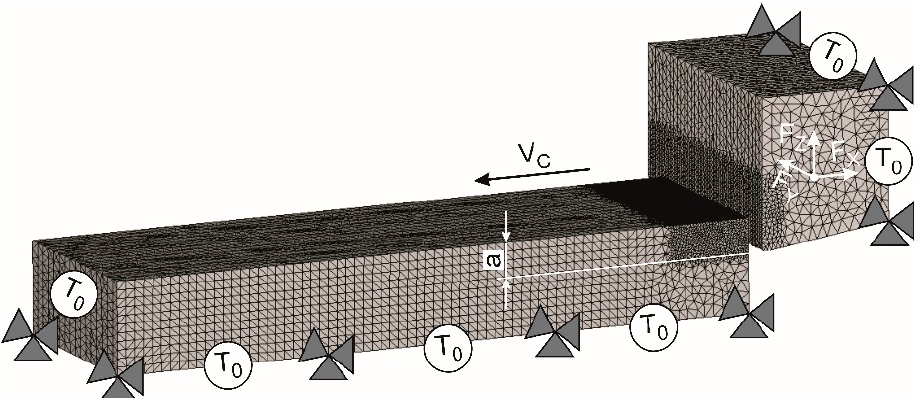
Figure 9. Initial geometry and boundary conditions of orthogonal cutting model.